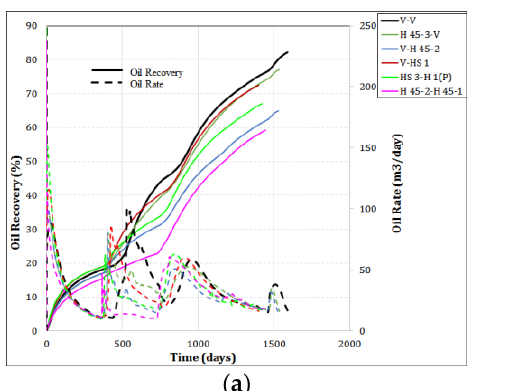
Figure 4. Feasibility factor of all of the combinations belonging to Category B. 4.3. Category C